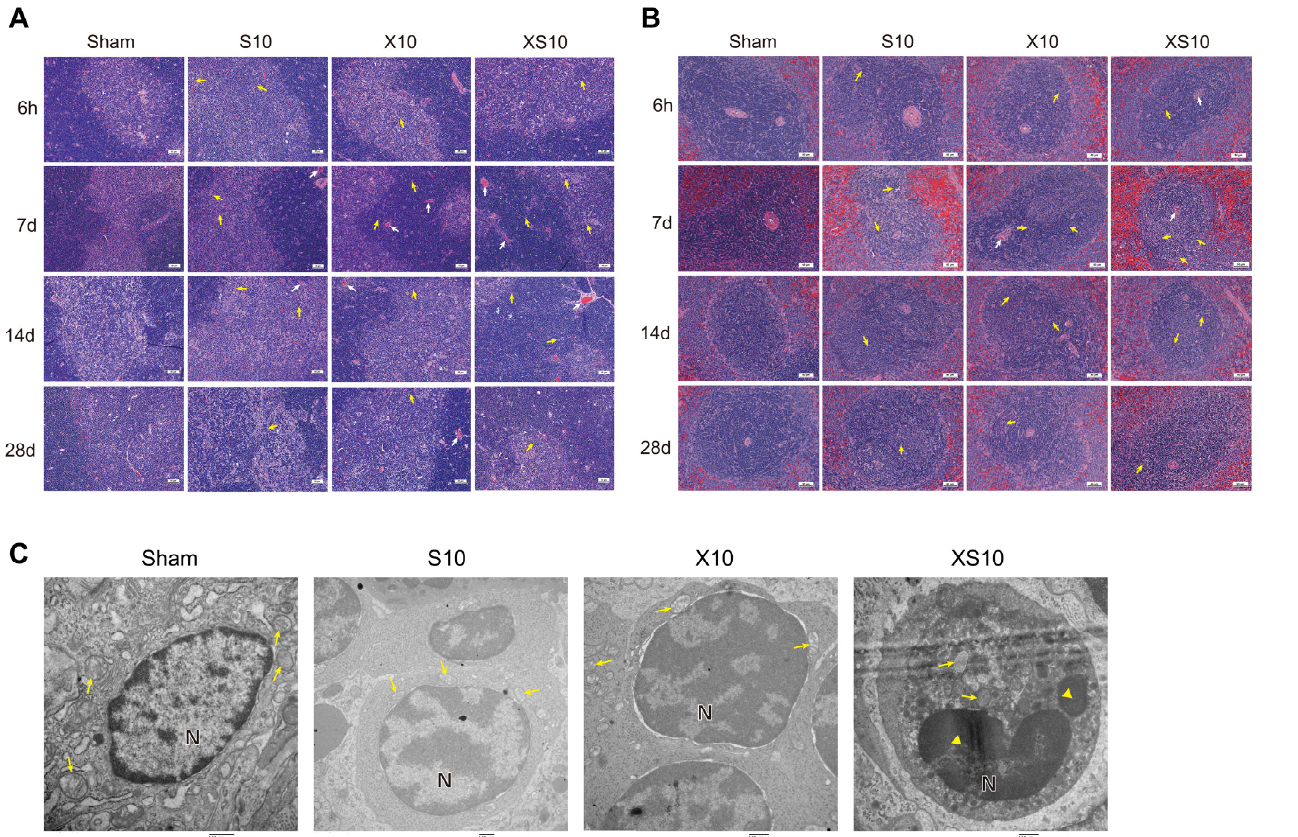
Figure 1. Exposure to multifrequency microwaves of 2.8 GHz and 9.3 GHz caused histopathological injuries to immune organs. Six- to eight-week-old adult male Wistar rats were exposed to 2.8 GHz microwaves (S10), 9.3 GHz microwaves (X10), or 2.8 GHz plus 9.3 GHz microwaves (XS10) at an average power density of 10 mW/cm 2 for 6 min. At 6 h, 7 d, 14 d and 28 d after exposure, rats in the Sham group, S10 group, X10 group and XS10 group were euthanized, and the immune organs, including the thymus and spleen, were removed. The tissues were processed and stained with hematoxylin-eosin (H&E), and pathological alterations in the thymus, spleen and bone marrow were observed. Representative images of thymus ( A ) and spleen ( B ) at indicated time points after exposure are shown (Scale bar =50 μ m). Moreover, the ultrastruc- tural injuries in the spleen were analyzed by transmission electron microscopy (TEM) at 7 d after exposure (( C ), Scale bar = 500 nm). Congestion was indicated by white arrow, while nuclear fragmentation of lymphocytes was indicated by yellow arrow in A and B ; Mitochondria are indicated by yellow arrows, and nuclear fragmentation are indicated by yellow trian- gles in C